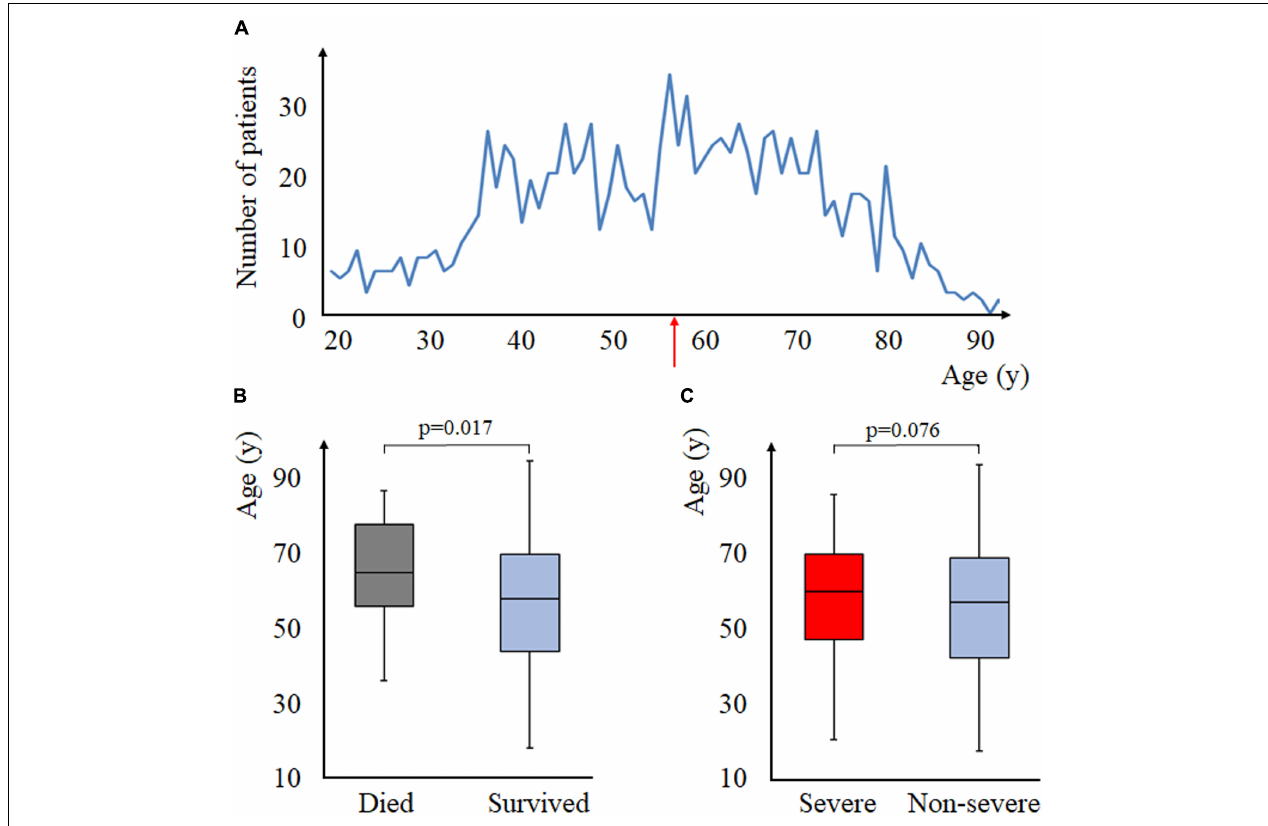
FIGURE 1 | Aging and acute pancreatitis (AP). (A) age-distribution of the study population, the red arrow indicates the median age of the population (that is, 58 years of age). (B) mortality and age (Mann–Whitney test). (C) severity and age (Mann–Whitney test).